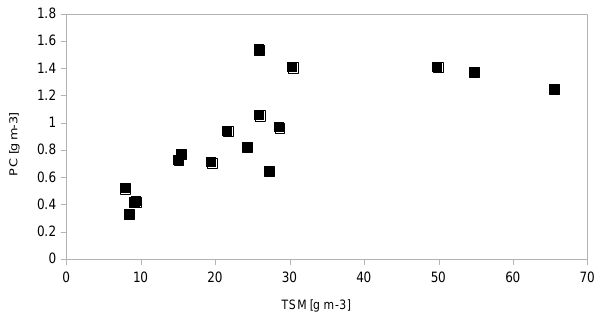
Fig. 13. Relationship between particulate carbon and total sus- pended matter concentration.